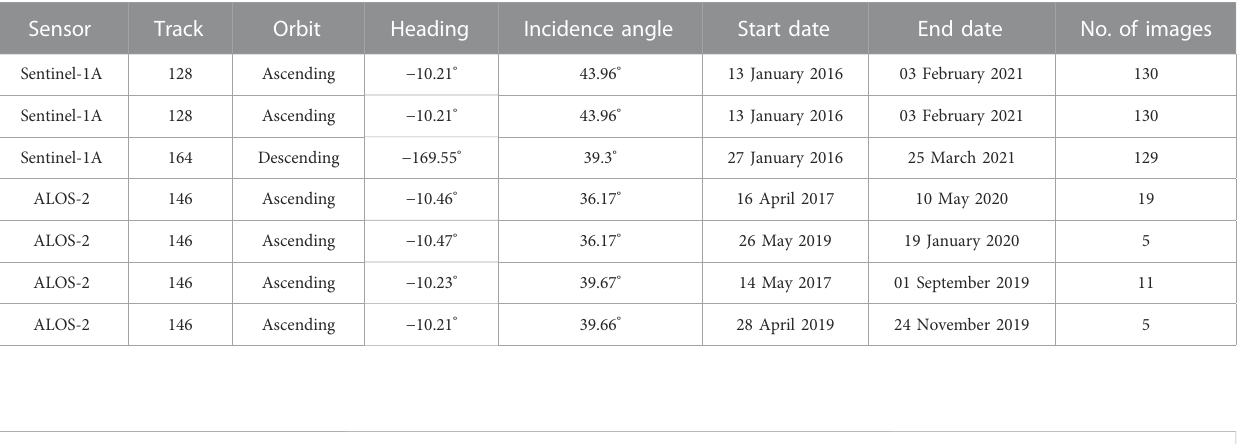
TABLE 1 Basic parameters of the SAR datasets used in this study.